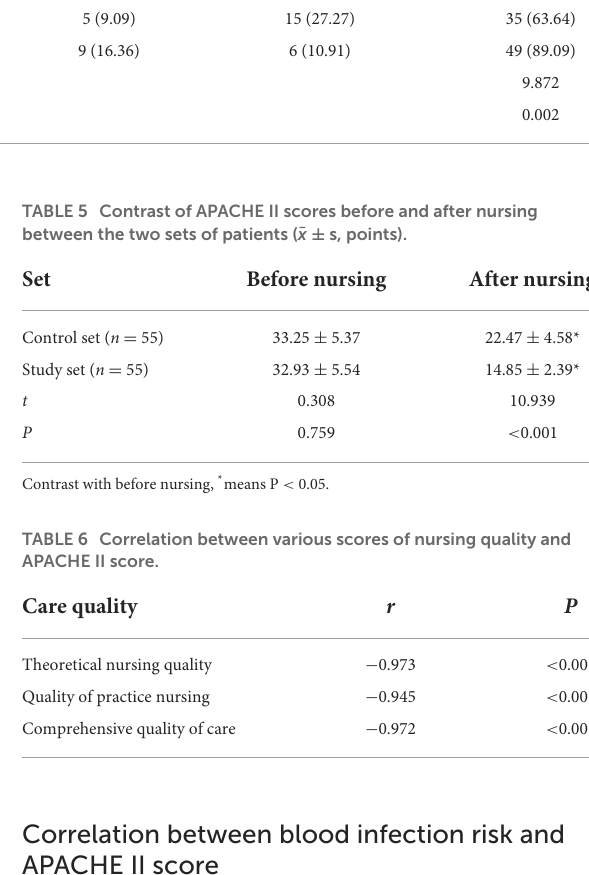
TABLE 4 Contrast of nursing satisfaction of two sets of patients. Set Very satisfied Satisfy Generally Dissatisfied Satisfaction